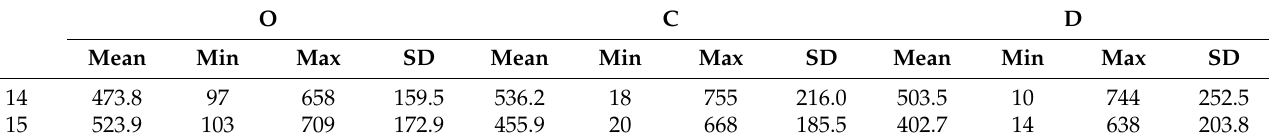
Table 9. Descriptive statistics of solar radiation at each test point on the 12th and 13th (W/m 2 ).